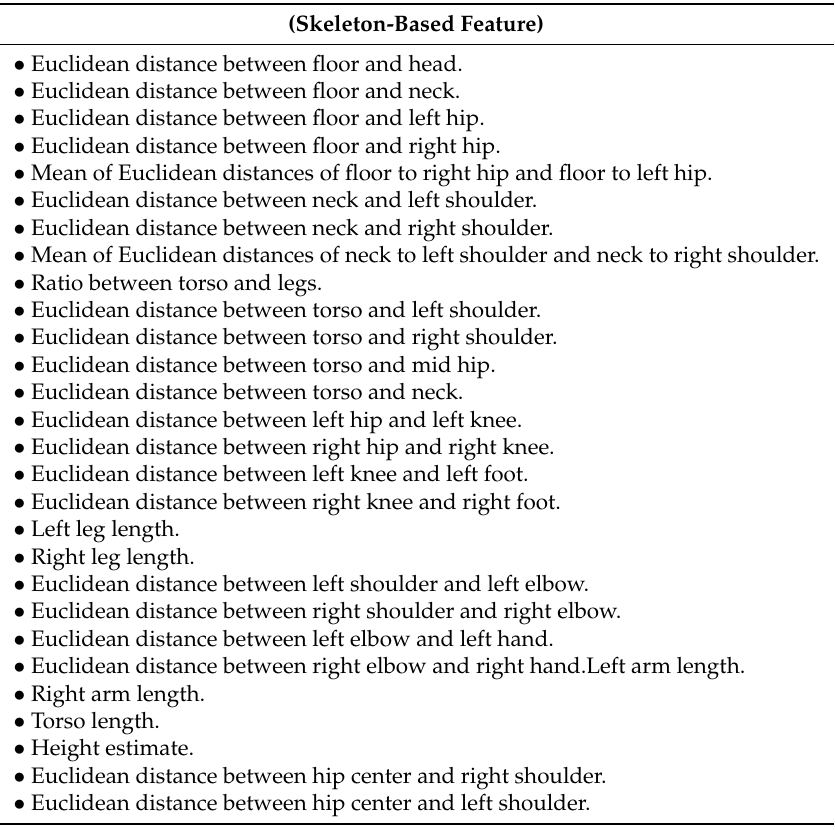
Table A2. Euclidean distance of selected skeleton segments.